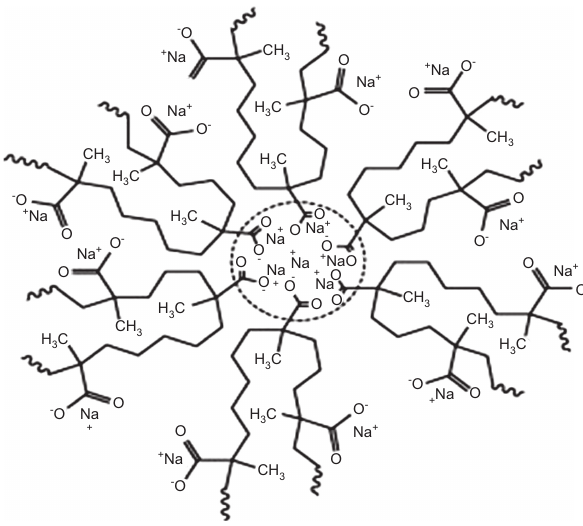
Figure 15 Self-healing mechanism in an ionomer after ballistic impact (reprinted with permission from [67]). Copyright 2008,